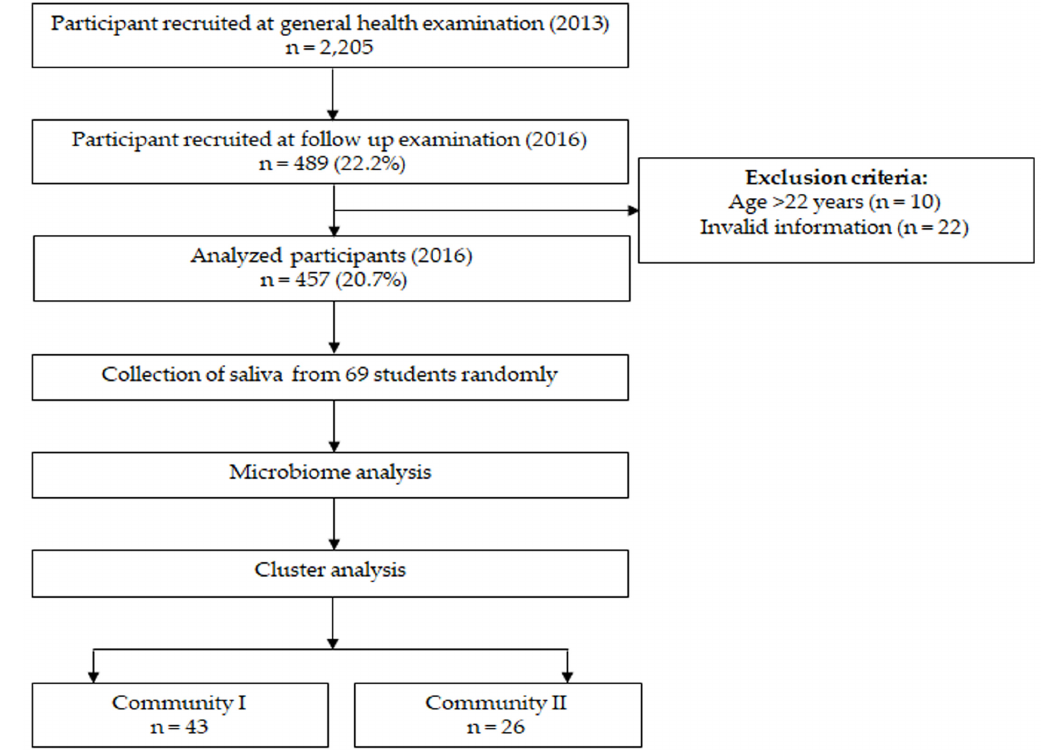
Figure 1. Flowchart of the study. Two communities were identified using k means clustering based on the salivary microbiome.